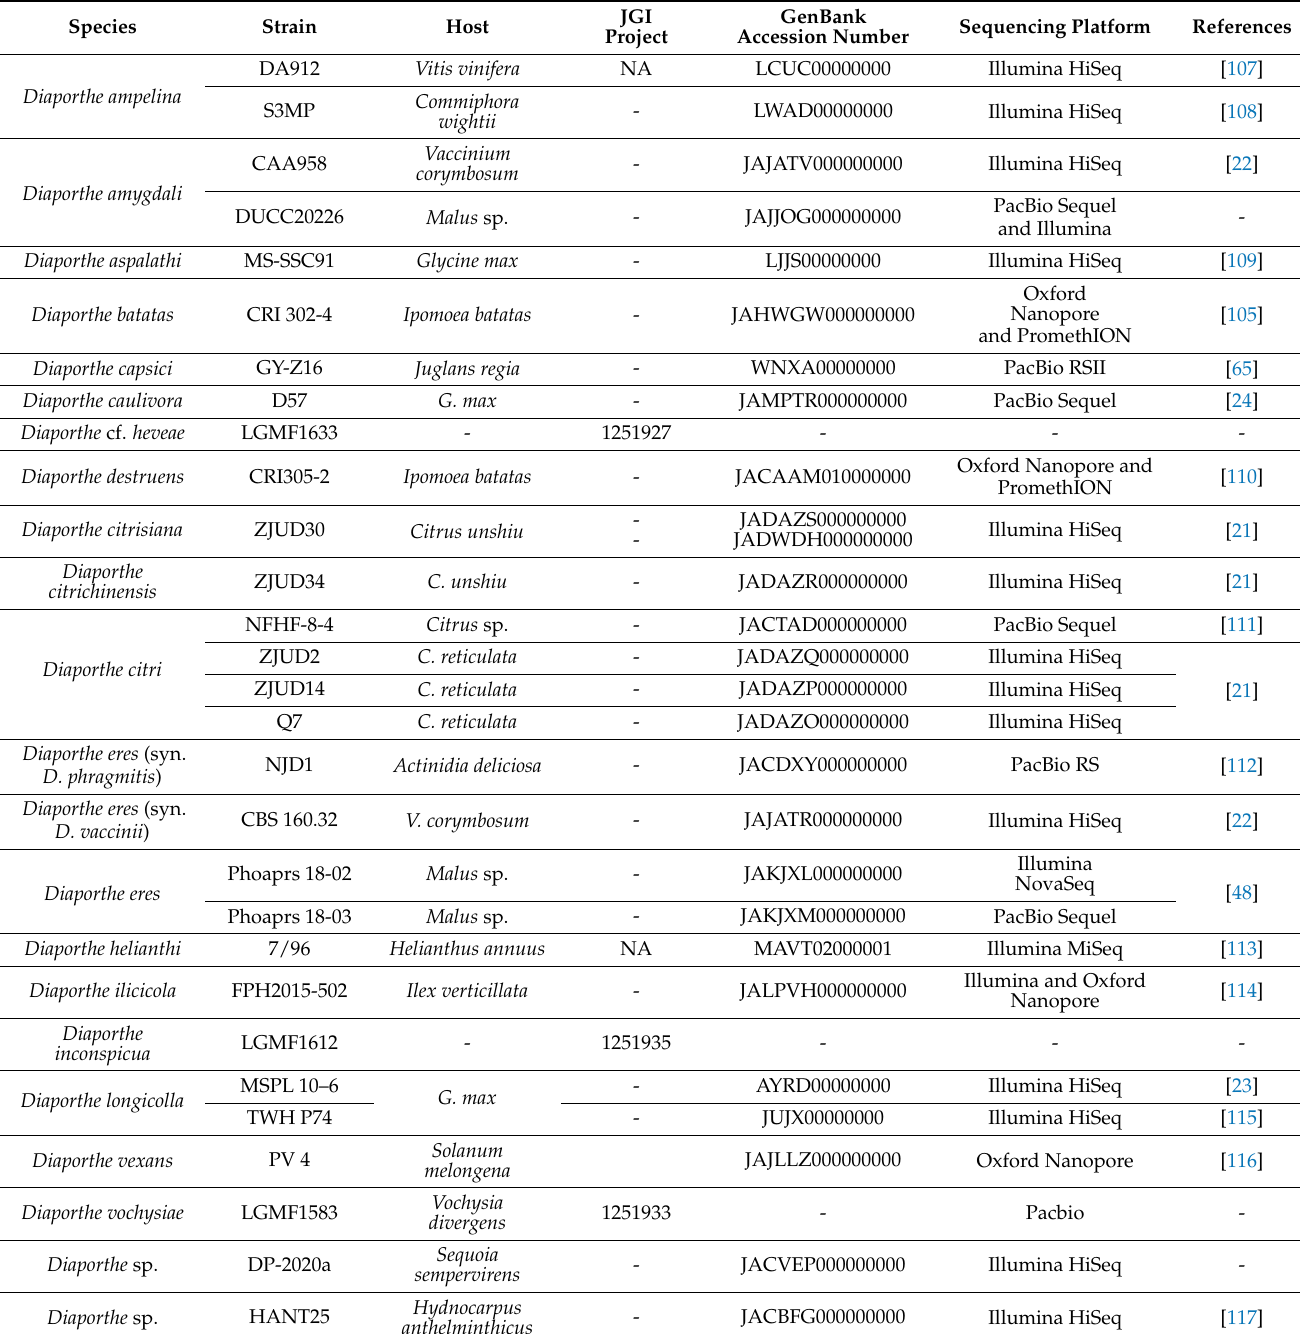
Table 2. Synopsis of all Diaporthe strains with genomes sequenced. (Note: NA stands for ‘not applicable’ meaning that the genome is available at the JGI Portal but has no Project